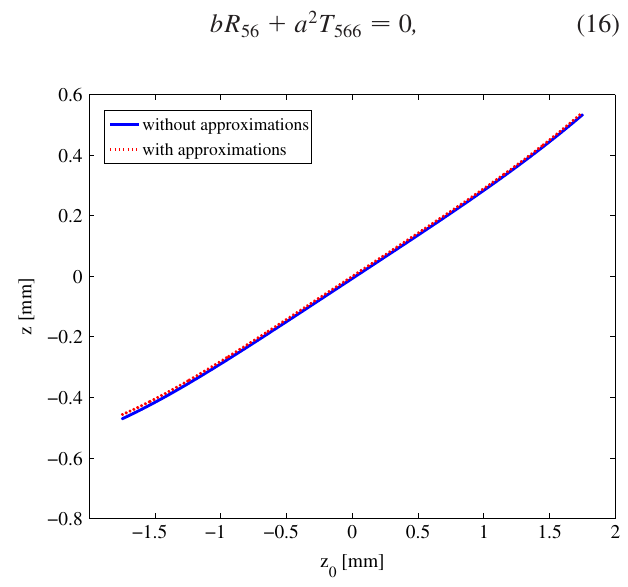
FIG. 3. (Color) Comparison between the compression obtained numerically in Eq. (13) without the approximations and the compression given by Eq. (15), i.e., derived from the approxi- mation in the power series for the energy variation of Eq. (12) and from the simplification due to the order analysis of Eq.